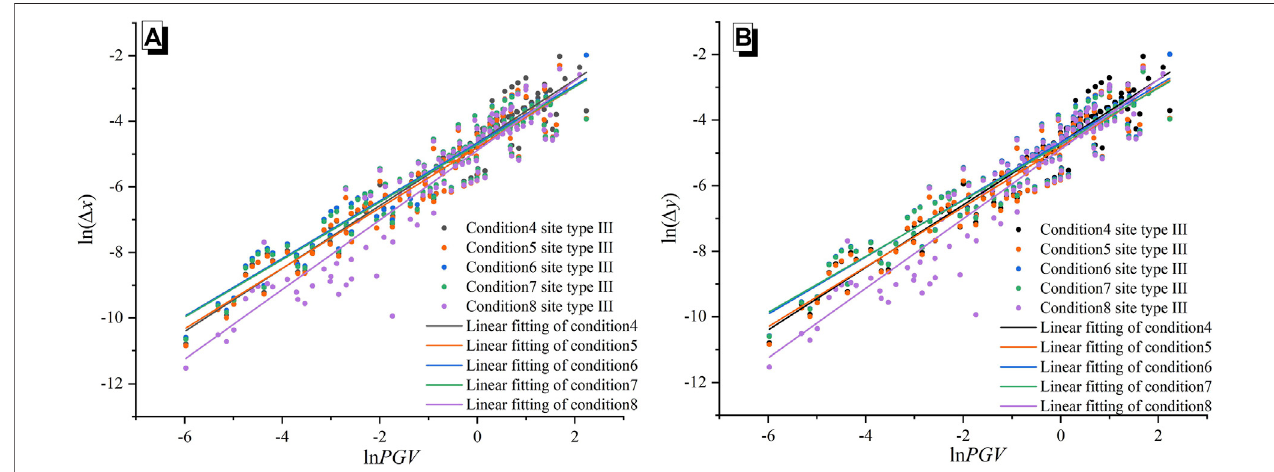
FIGURE 9 | The statistics for the structural seismic demand model under working conditions 4 – 8 (the PGV). (A) the amount of the ring joint opening; (B) the